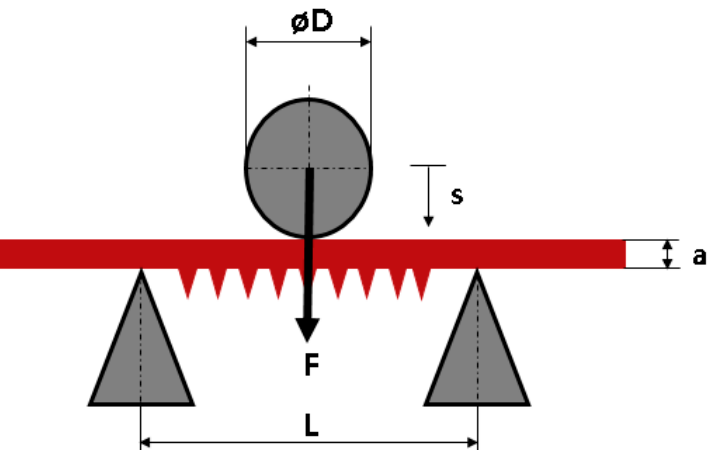
Figure 6. Schematic 3-point bending test-setup; D: diameter of the bending die; L: bearing distance; a: sheet thickness; s: travel range of the bending die.